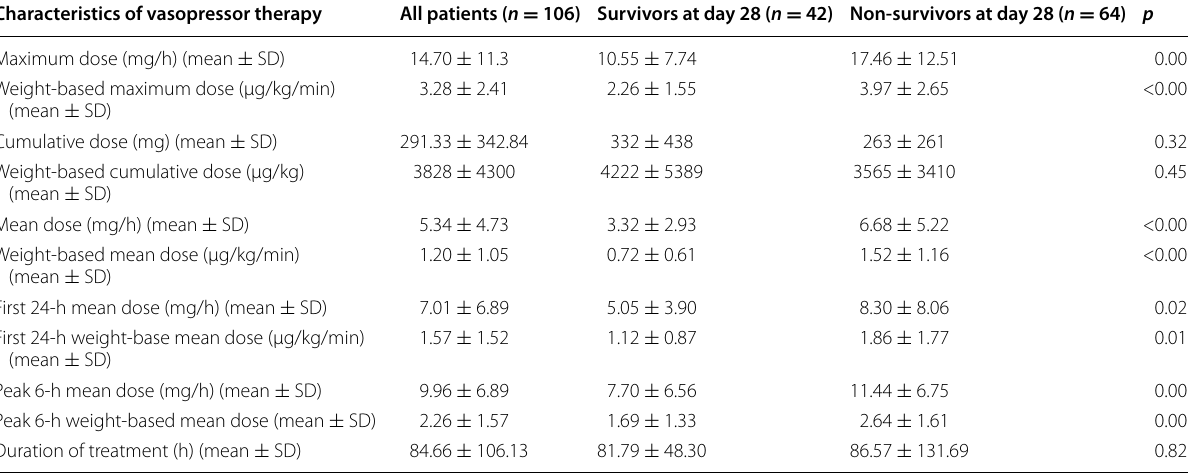
Table 3 Characteristics of vasopressor therapy according to survival Characteristics of vasopressor